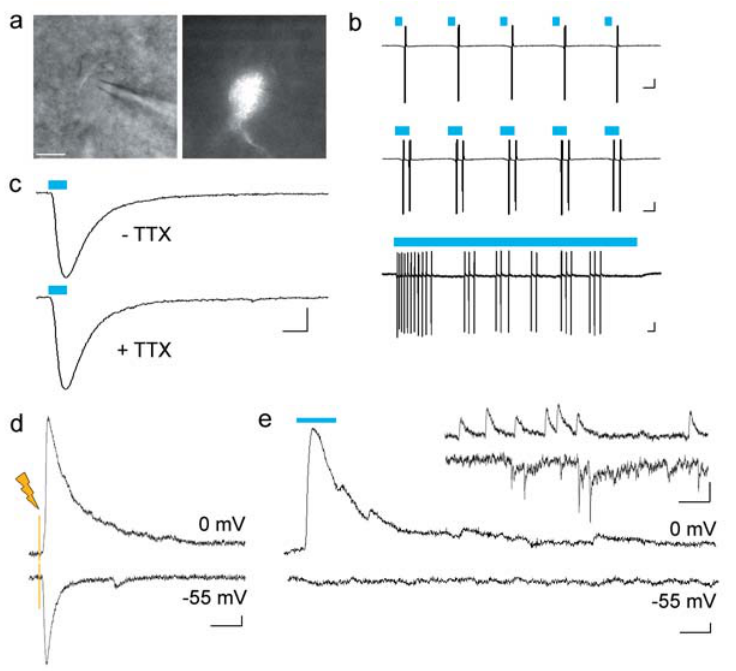
Figure 3. Functional demonstration that the Cre-activated AAV vector is cell-type specific. Pv-cre mice were injected with AAV-LS 2 L- ChR2mCherry and acute slices for electrophysiological recording were prepared. (a–c) Light stimulation directly elicited depolarizing responses in ChR2-positive neurons. DIC and fluorescent images of a ChR2-positive cell targeted for recording (a); scale bar: 10 m m. Spike responses to light stimulation of increasing duration (7, 14, and 500 ms as indicated by blue line) were recorded in cell-attached mode (b); scale bars: 40 pA, 25 ms. ChR2-mediated current was maintained in the presence of TTX. (c); scale bar: 50 pA, 10 ms. (d) Electrical field stimulation evoked both inhibitory post-synaptic current (upper trace, holding potential set to the reversal potential for AMPA/NMDA-mediated current, 0 mV) and excitatory post- synaptic current (lower trace, holding potential set to the reversal potential for GABA-mediated current, 2 55 mV), recorded in a pyramidal cell in whole-cell voltage-clamp mode; scale bar: 40 pA, 20 ms. (e) Light stimulation specifically evoked inhibitory post-synaptic current (upper trace), no excitatory post-synaptic current was detected (lower trace); scale bar: 20 pA, 20 ms. Inset, both inhibitory and excitatory spontaneous synaptic events were detected using the same recording conditions; scale bar: 20 pA, 50